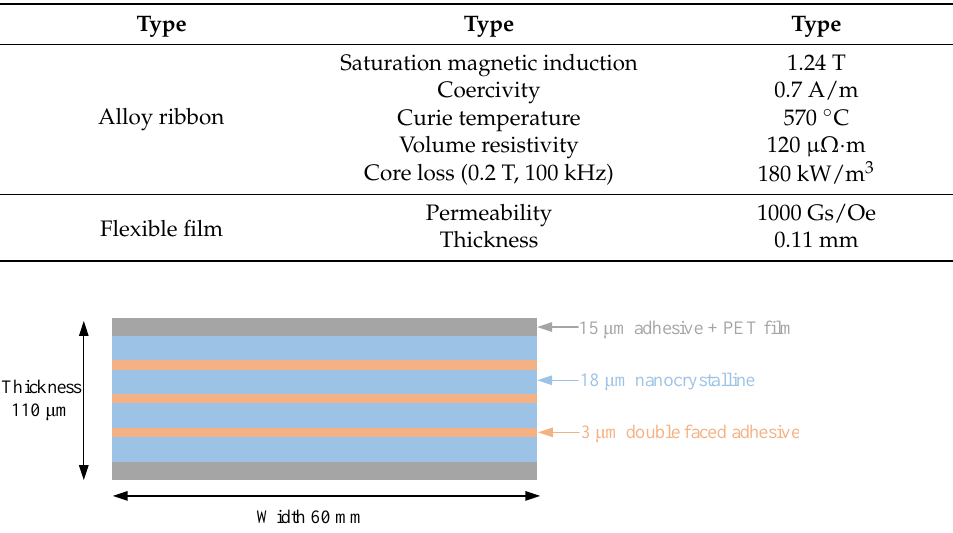
Figure 9. The layered structure of the nanocrystalline alloy film.